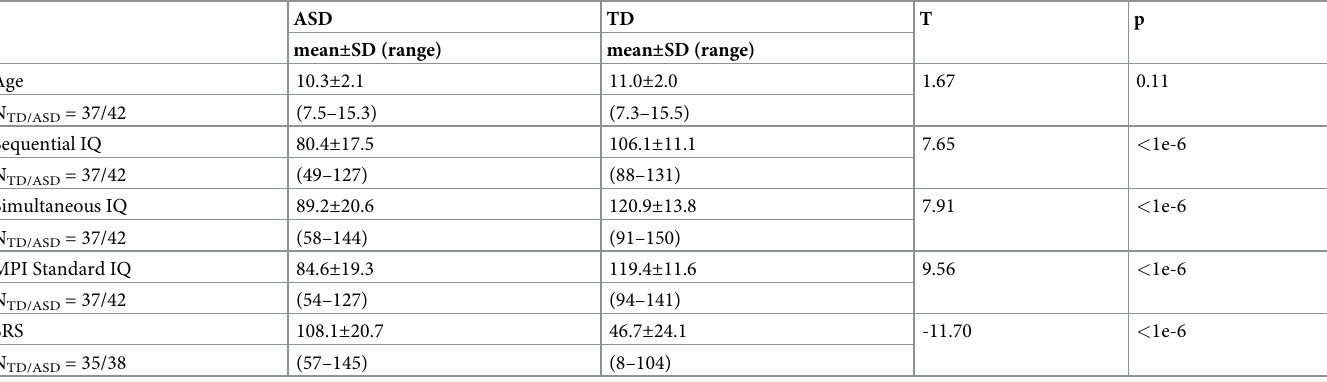
Table 1. Characteristics of the pediatric samples included in analysis of MEG visual gamma oscillations.